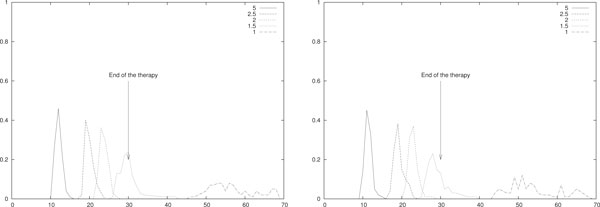
Probability density function, weekly ACI mono-therapy. Empirical evaluation of ϱ(ter) for different piece-wise constant (left) and impulsive (right) weekly ACIs. In (left) bi = w* · 7 · 104/(V A) for i = 1, . . . , 30 and in (right) wi = w* · 7 · 104 for i = 1, . . . , 5 where w* ∈ {5, 2.5, 2, 1.5, 1}. The value of w* is given in the figure, all the other parameters are as in Table 3. The densities are obtained by performing 102 simulations for each value of w*.